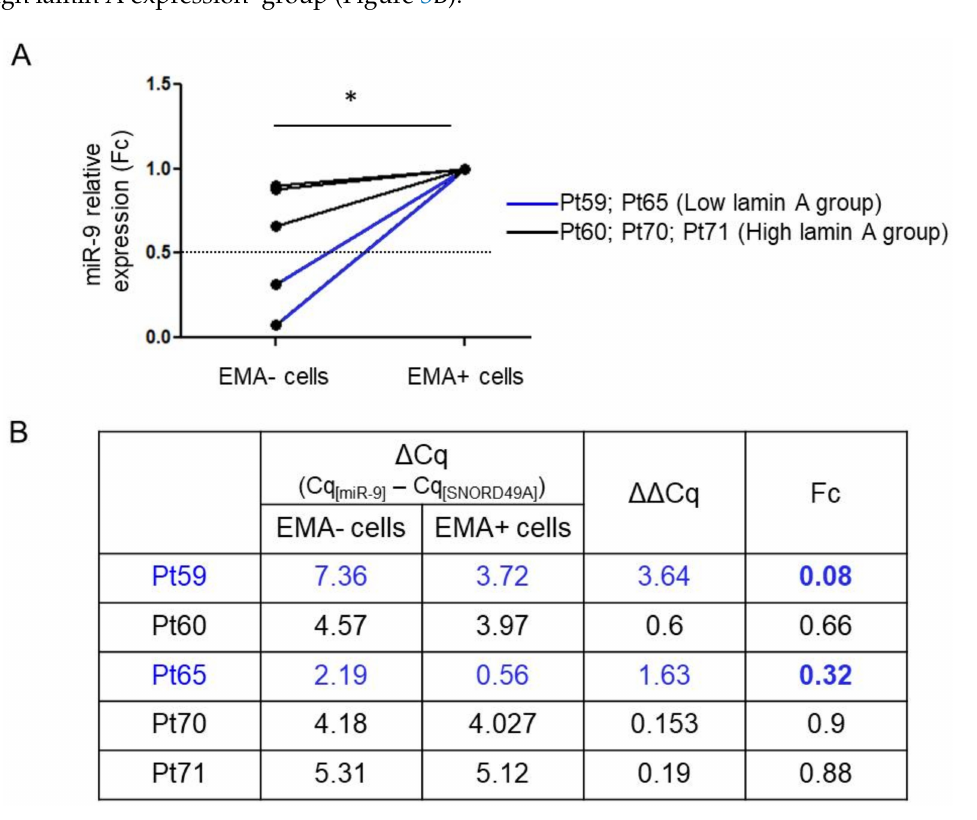
Figure 3. miR-9 expression in carcinoma cells according to lamin A expression, after FACS isolation. ( A ) miR-9 relative expression (Fc = fold change) quantified by RT-qPCR analysis according to the EMA expression, reflecting lamin A expression ( p = 0.03, Paired Wilcoxon test). *: p < 0.05 ( B ) miR-9 relative expression and fold change (Fc) of EMA − cells compared to EMA + cells in 2 patients from the ‘Low lamin A expression’ group (Pt59 and 65, in blue) and in 3 patients from the ‘High lamin A expression’ group (Pt60, 70 and 71, in